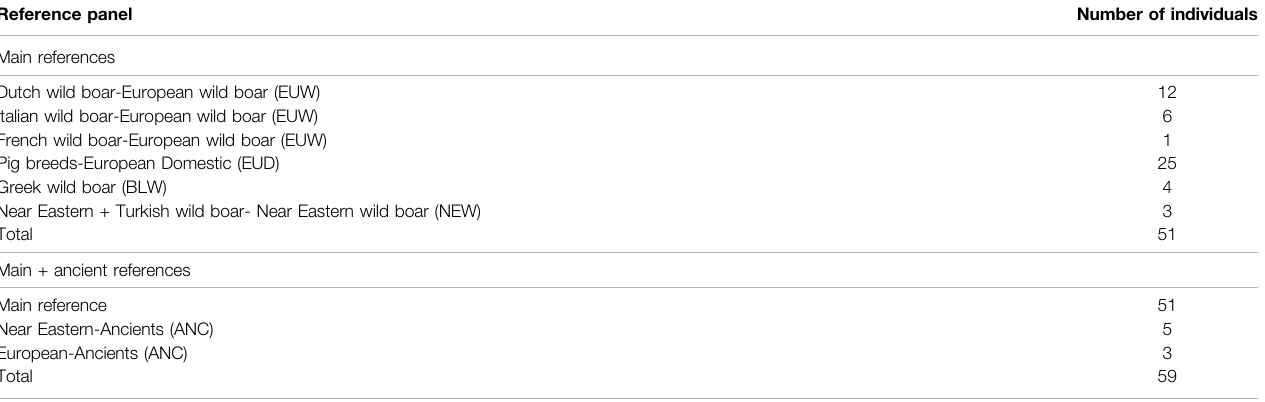
TABLE 2 | Reference panels with their respective number of